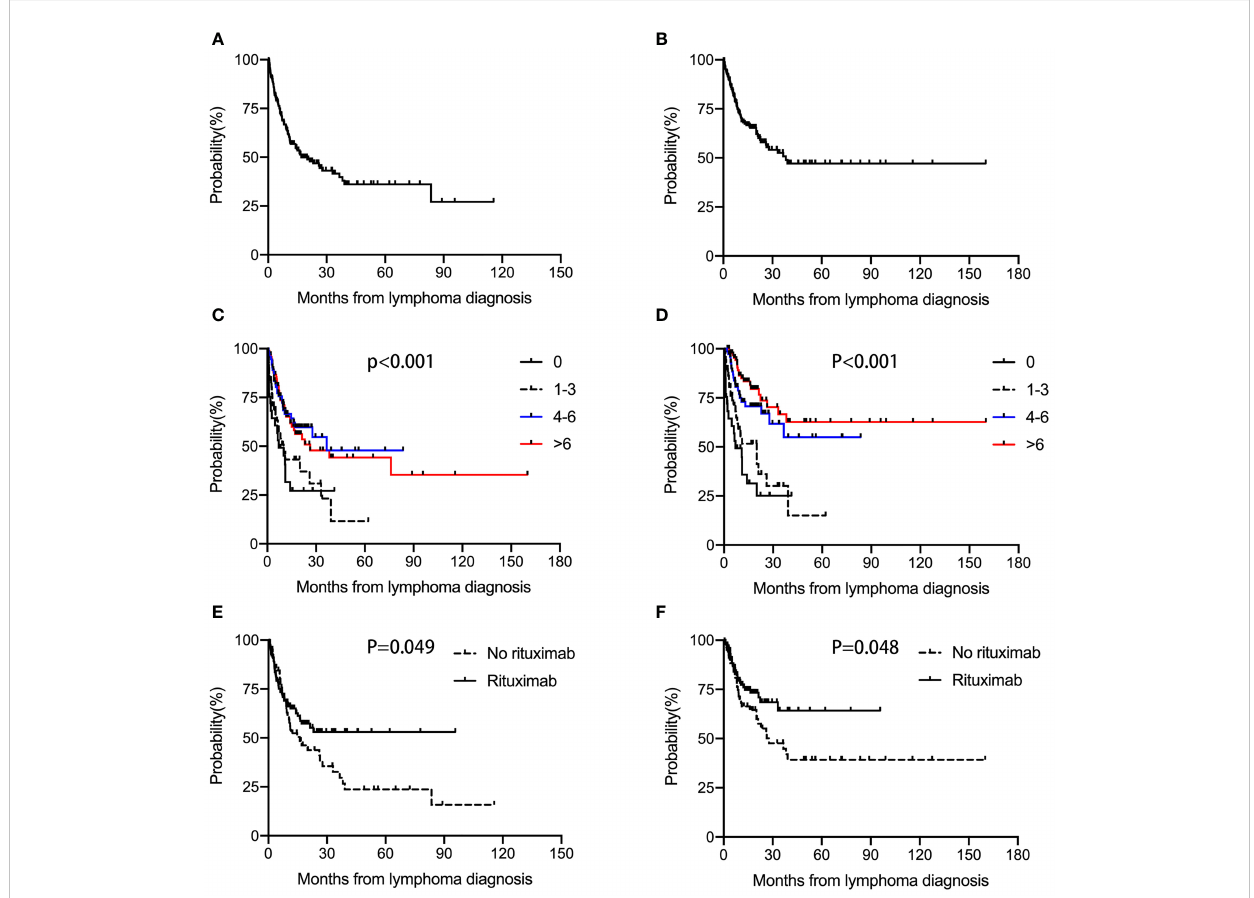
FIGURE 1 PFS and OS in HIV-associated DLBCL patients. Median PFS (A) and OS (B) were 17 months and 38.1 months, respectively. Median PFS times in the 0, 1-3, 4-6, and >6 cycles chemotherapy cohort were 7.1 months, 10.1 months, 36.5 months, and 26.4 months, respectively (p<0.001) (C) . Median OS times were 7.1 months, 20.0 months, not reached, and not reached, respectively (p<0.001) (D) . Median PFS times in the no received rituximab and received rituximab groups were 16 months and not reached (p=0.049) (E) . Median OS times were 27.7 months and not reached (p=0.048) (F)